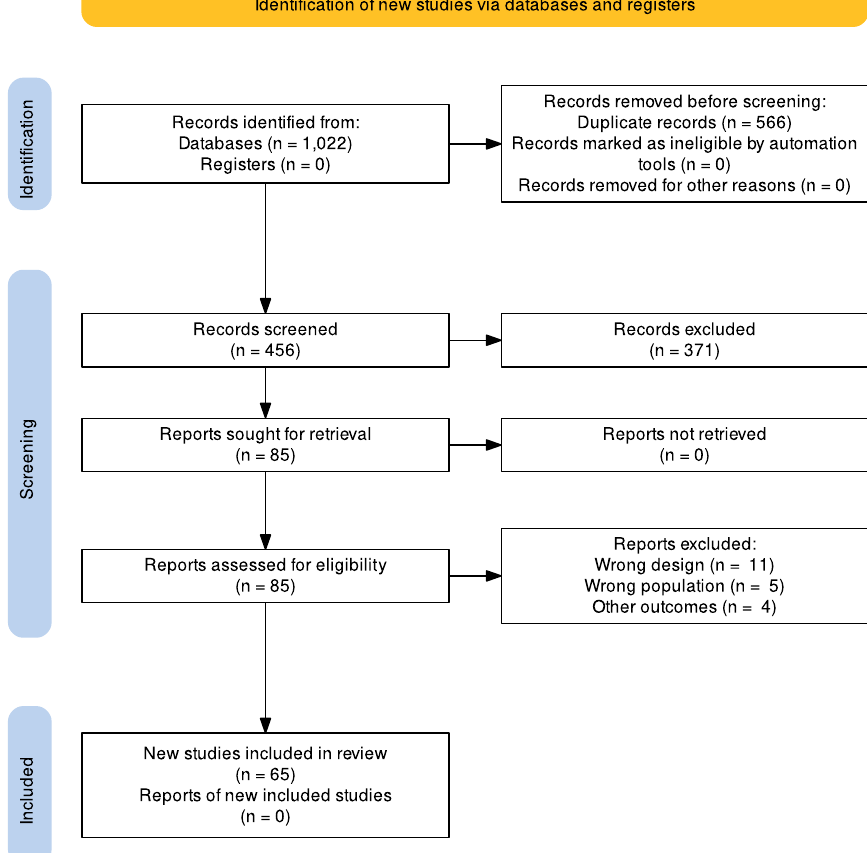
Figure 1. PRISMA flow chart of the studies selection process.